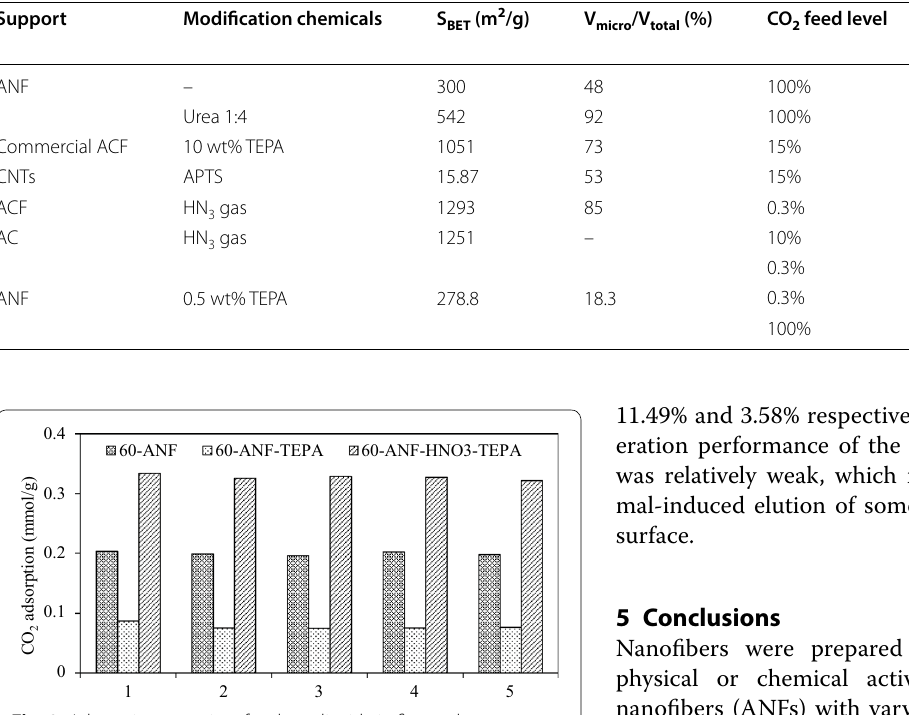
Fig. 8 Adsorption capacity of carbon dioxide in five